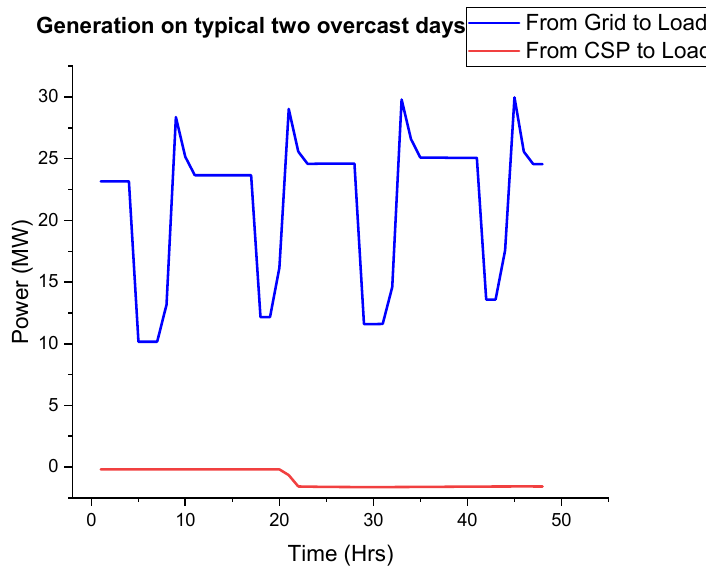
Figure 24. Two typical consecutive days with bad CSP production.